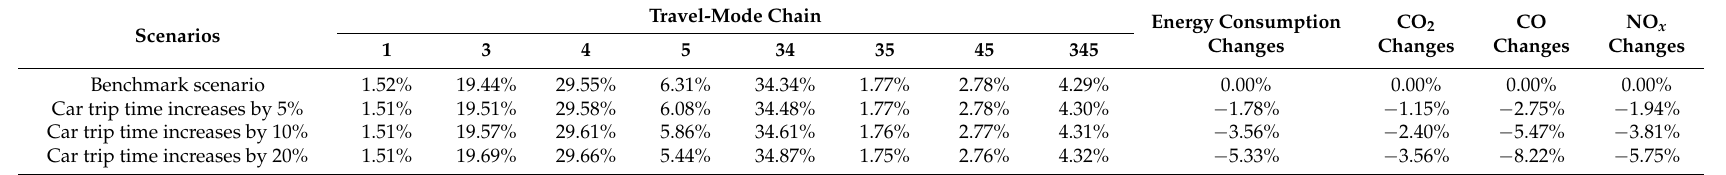
Table 12. Comparison of energy consumption and emissions under different car trip times in the holidays.